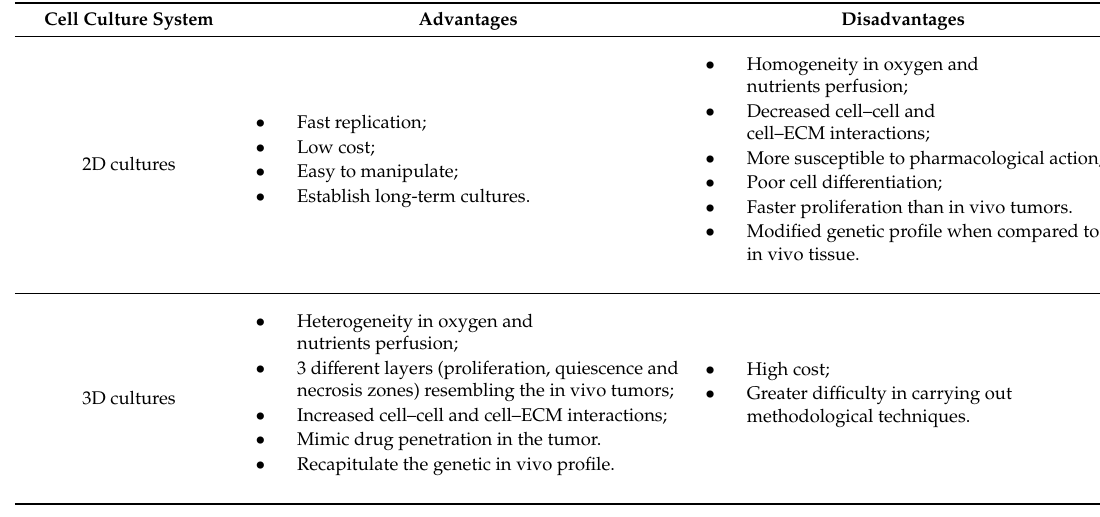
Table 1. Di ff erences between conventional 2D monolayer and 3D spheroid